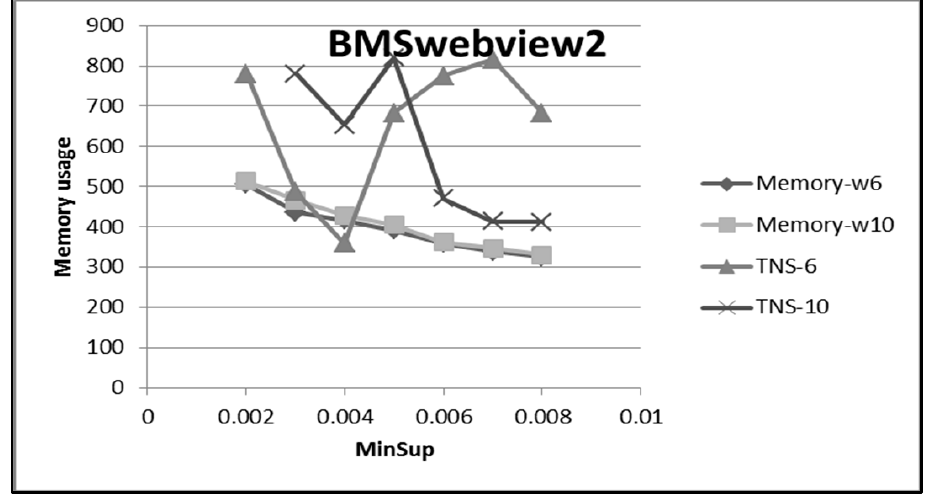
Figure 26. Comparison of memory usage for the TNS with the TRuleGrowth algorithm for (BMS webview2) dataset.